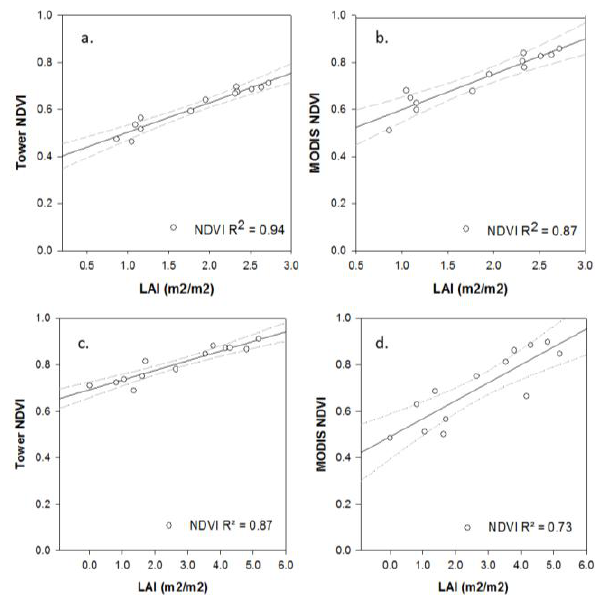
Figure 1. Correlations between LAI and NDVI in early (a. and b.) and intermediate successional plots (c. and d.) in the Santa Rosa National Park, Guanacaste. Dashed lines represent the 99% confidence intervals.